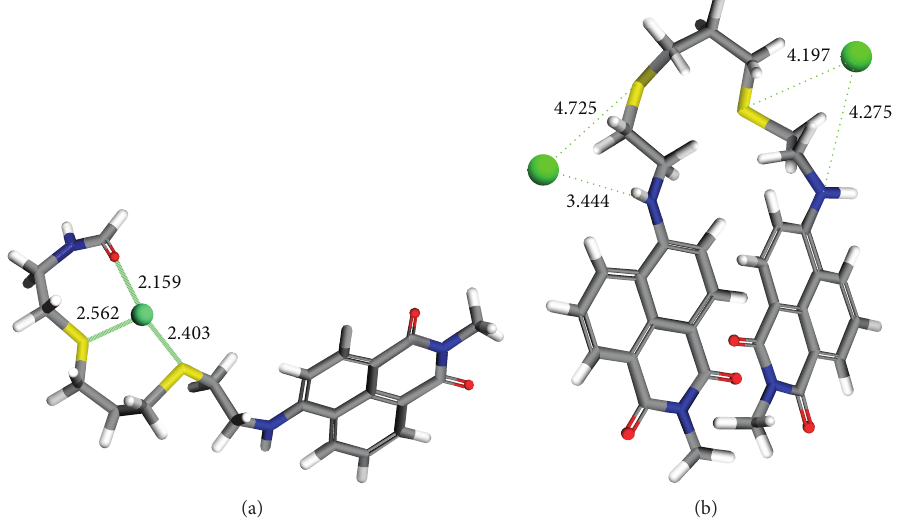
Figure 4: Optimized structures of (a) 1 -Hg 2+ and (b) 2 -Hg 2+ complexes from MD with local density approximation (LDA) of local functional PWC. (The distances between Hg 2+ and donor atoms are indicated in ˚A.)